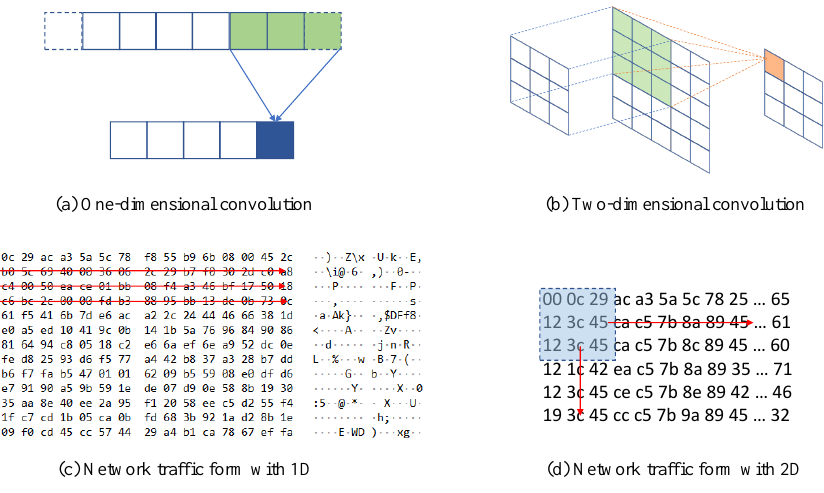
Figure 5. The structure of 1D and 2D convolution on network traffic